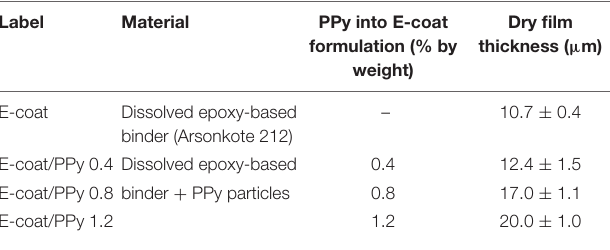
TABLE 2 | Coatings identification (labels), fillings of each sample and their dry film